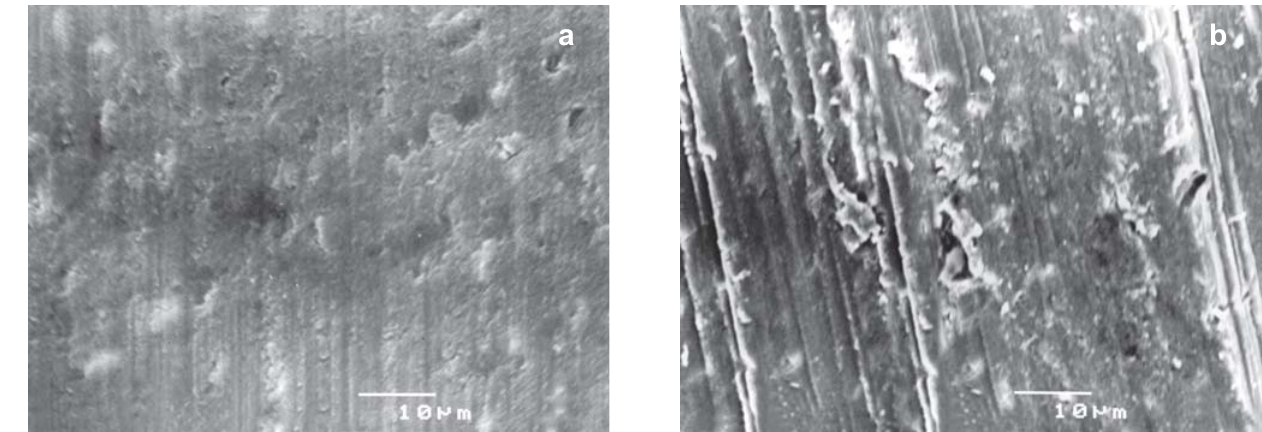
FIGURE 3- Dentin surface cut by: a) carbide bur; b) diamond bur. (Original magnification 1500X, bar=10 µm)